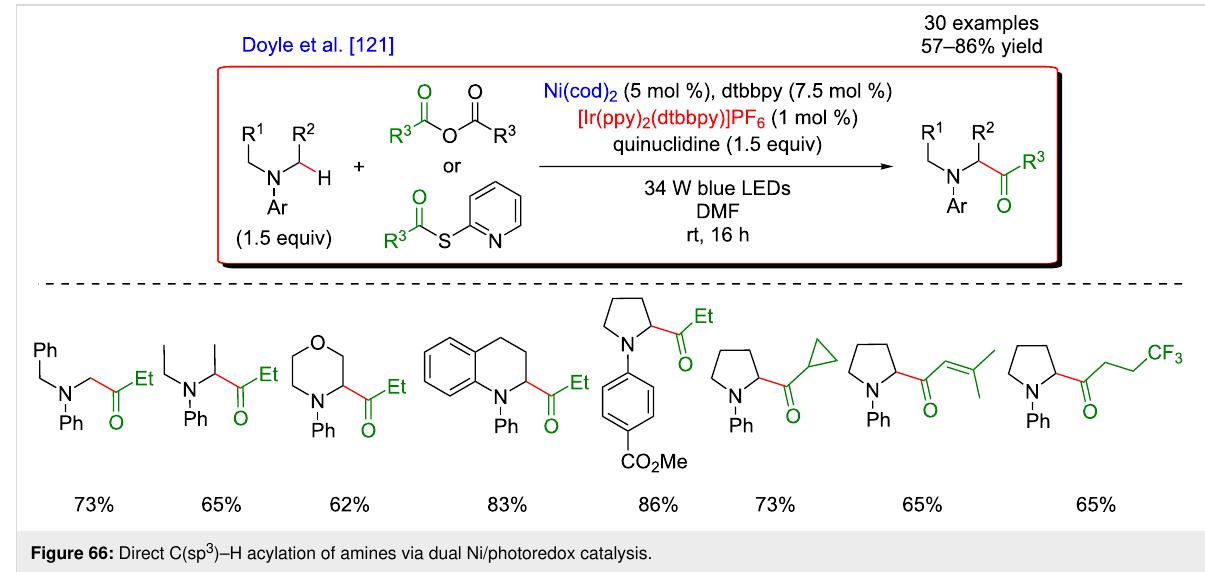
Figure 66: Direct C(sp 3 )–H acylation of amines via dual Ni/photoredox catalysis.